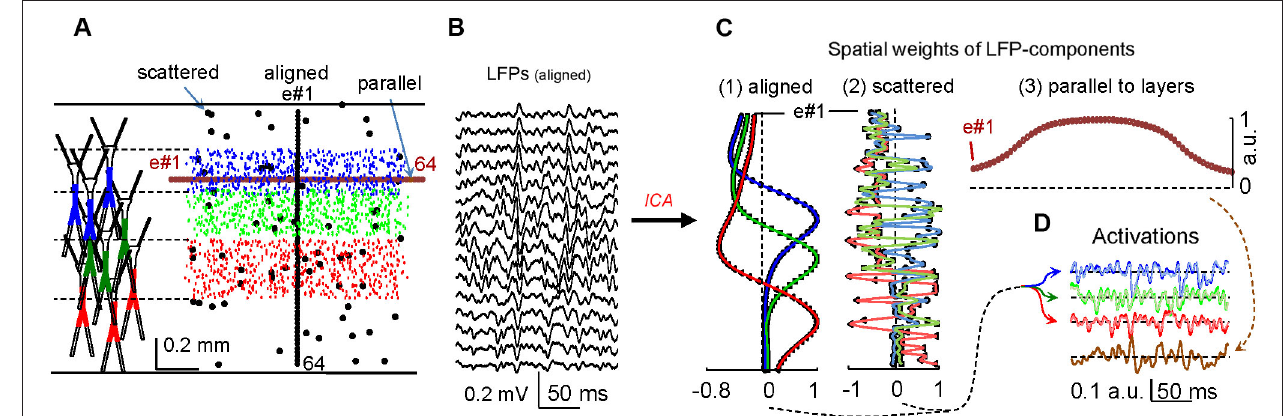
LFPs obtained at selected sites under configuration (1). (C) Spatial weight curves of the LFP components obtained by the ICA. Configurations that span vertically (1 and 2) yielded three LFP components with an identical temporal activation (D) , although only the aligned group offered a smooth curve matching the respective synaptic territories. Superimposed tracings in solid and feeble colors belong to ICA-derived and original activations, respectively. Recordings made parallel to the layers containing cell bodies (3) do not discriminate components as only one is obtained with a temporal activation that is a mix of all sources (in